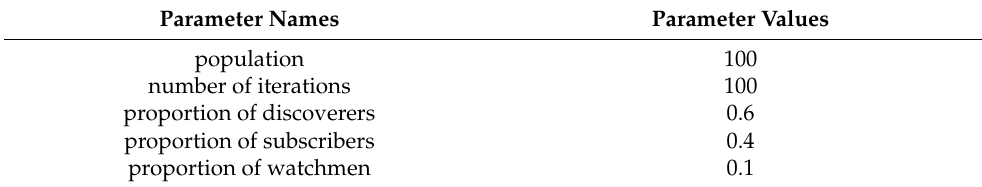
Table 3. Initialization parameters of SSA.